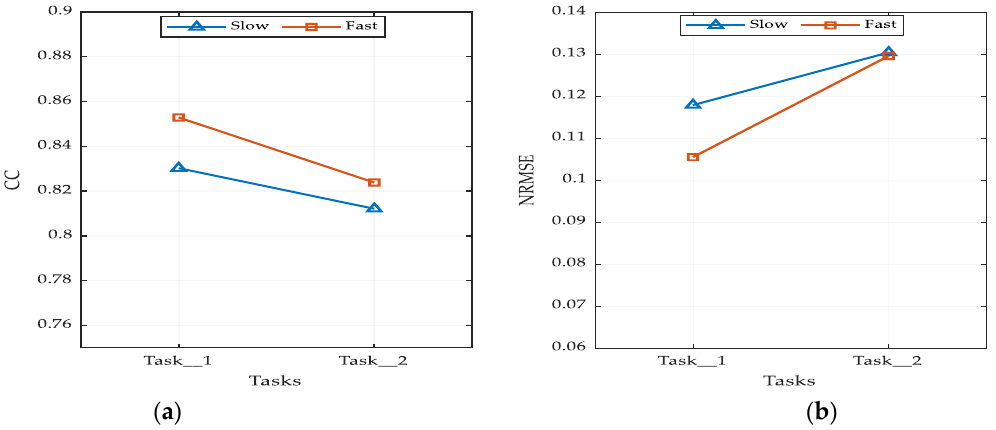
Figure 12. Impacts of speed and tasks on prediction performance. ( a ) Performance in terms of CC index; ( b ) performance in terms of NRMSE index.